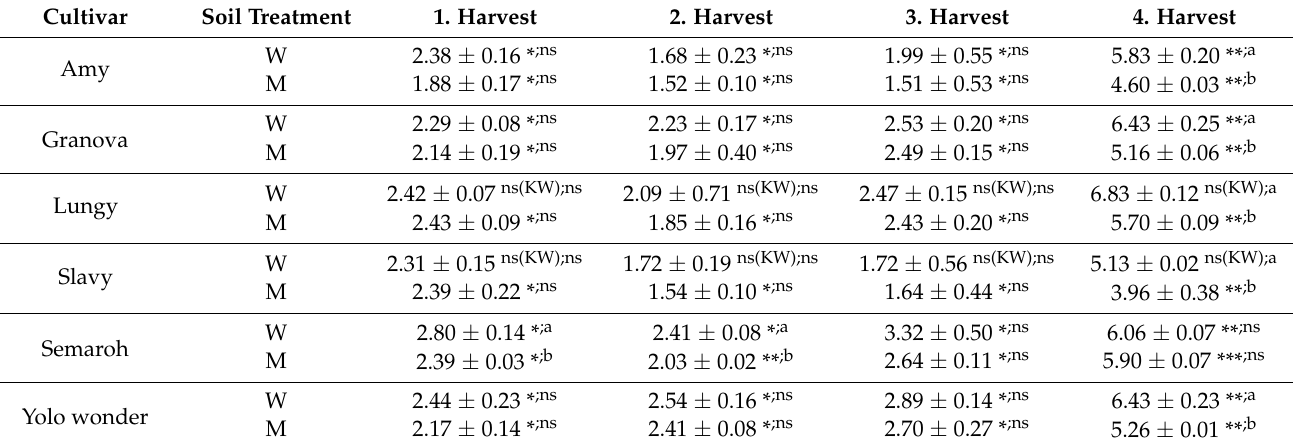
Table 5. Content of soluble solids in % (Means ± Standard error) for individual harvests.